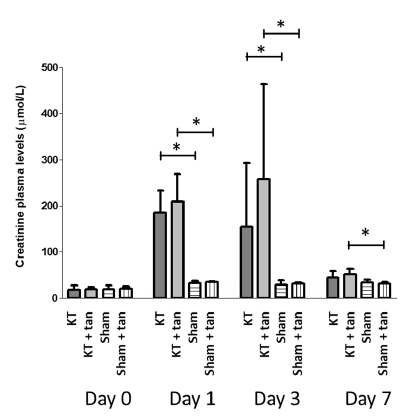
Figure 4. Tannic acid injection was ine ff ective to improve renal function recovery after cold ischemia– reperfusion in kidney graft model with 6 h of cold preservation. Rats were subjected to sham or kidney transplantation with bilateral nephrectomy with or without prior injection of tannic acid. Renal function was evaluated by creatinine plasma levels concentrations. n = 7-8 in transplanted groups and n = 6 in sham groups, values are mean ± SD, * p < 0.05. Biomolecules 2020 , 10 , 439